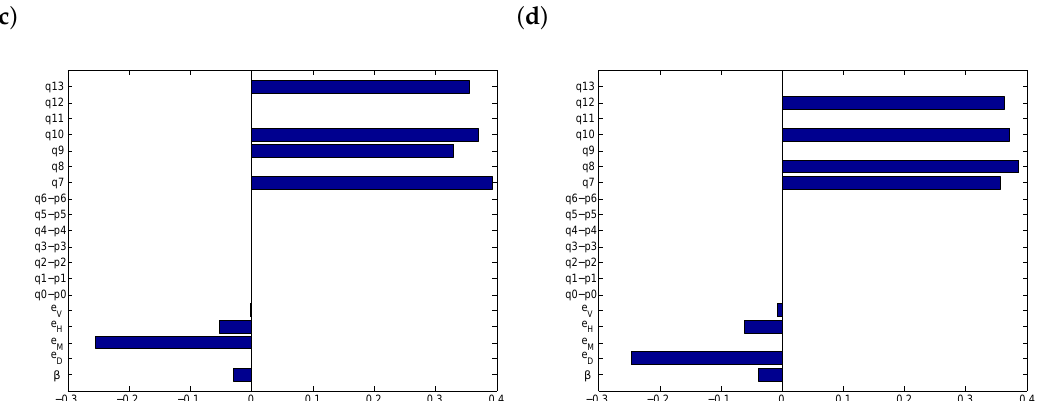
Figure 7. PRCCs after vaccine introduction. ( a ) Vaccination is the only option available; ( b ) all options and their combinations are in use; ( c ) when physical distancing is not possible; ( d ) when masks are not available. All values are as in Table 1, except that we constrained 0 ≤ q 7 ≤ 0.142 in ( b – d